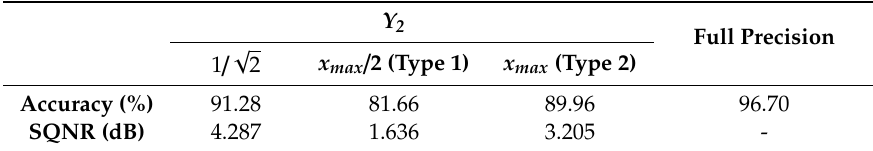
Table 3. Prediction accuracy of the multilayer perceptron neural network for di ff erent representation levels of the binary